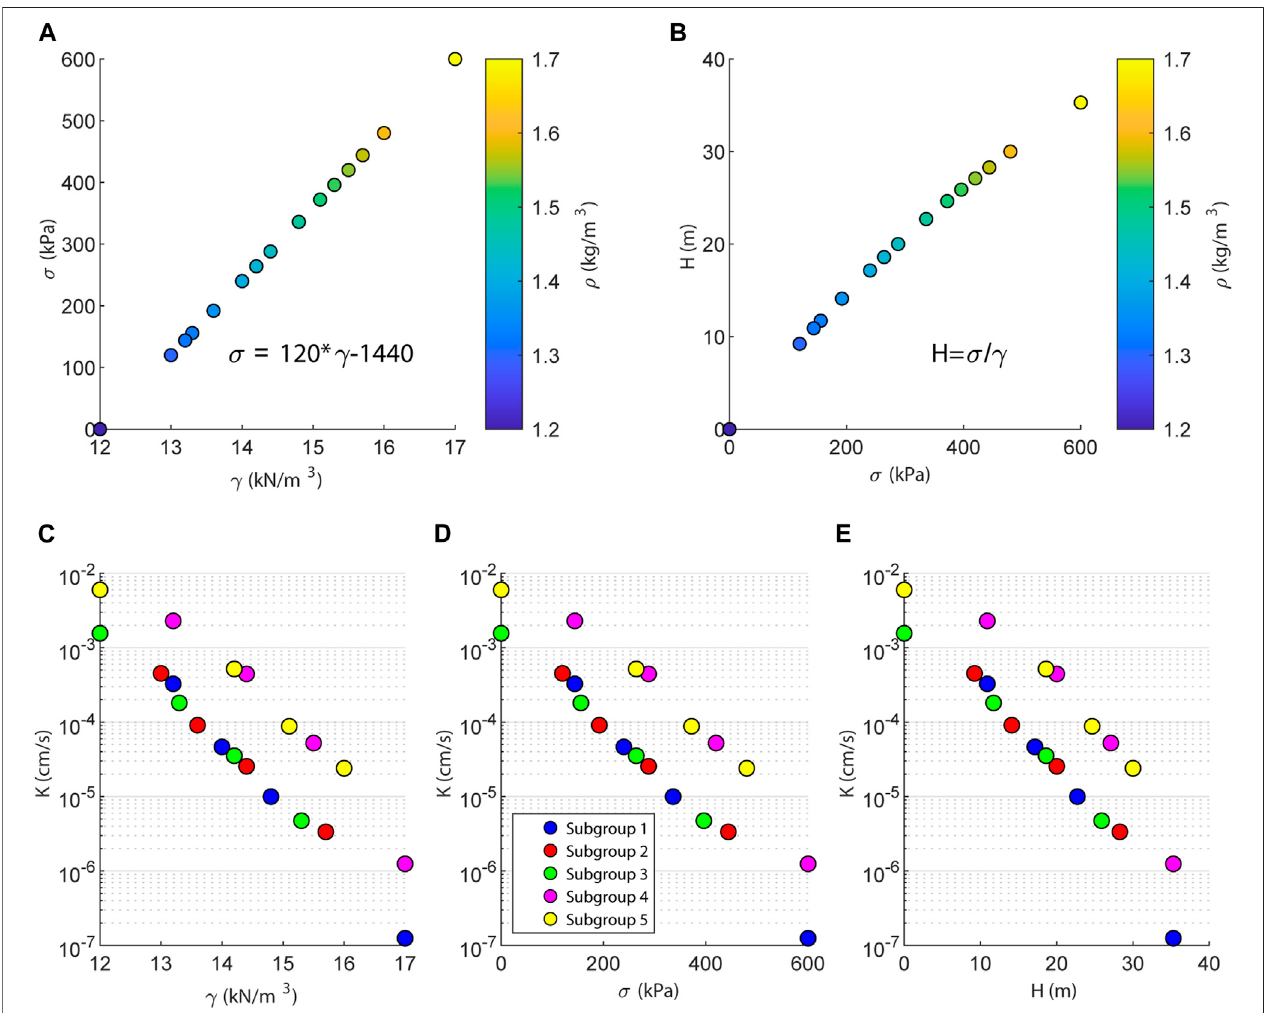
FIGURE 7 | Results of permeability analysis. (A,B) σ , γ , and ρ relationships by which H is computed. (C – E) determined K as function of γ , σ , and H. The data to which the plots are referred are reported in Table 3 .